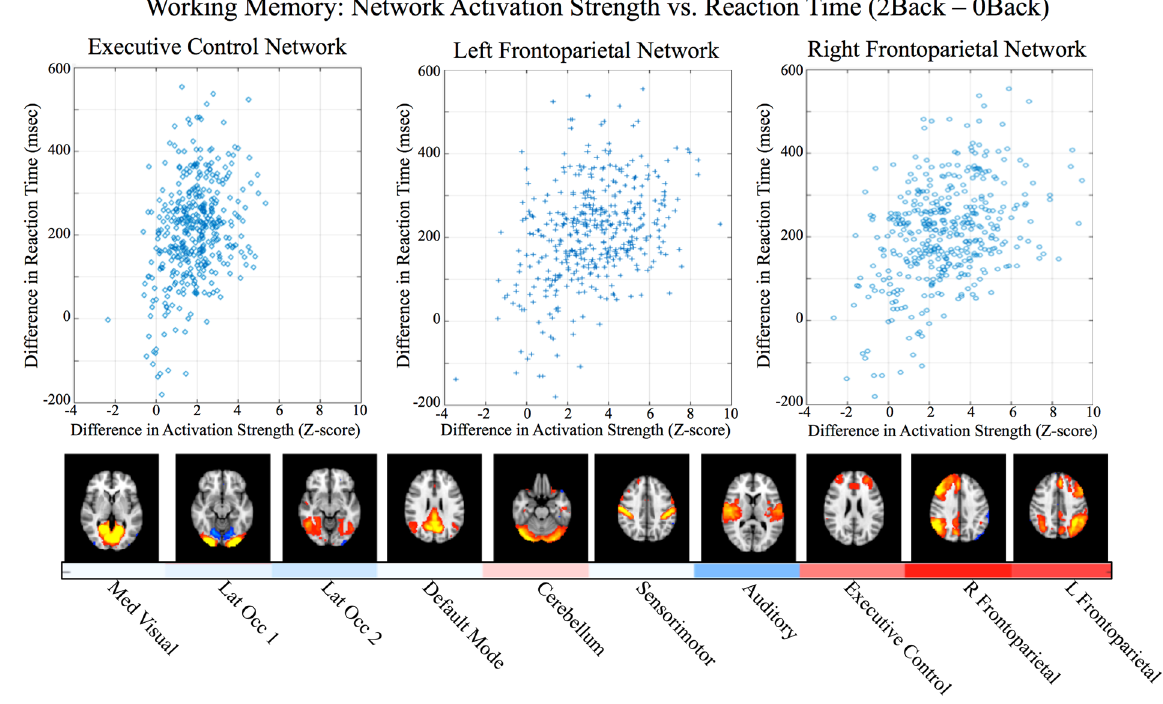
Figure 3. Working Memory Task. Activation strength of each network is shown in the color bar at the bottom of the network images ([red/white/blue] corresponding to range of Z-values of [ + 6/0/6]), with cerebellum, executive control, and left and right frontoparietal networks significantly activated (p < 0.0001, corrected). All other networks are suppressed (p < 0.02, corrected). The difference in brain network activation (2B-0B) was related to the difference in reaction times (2B-0B) for the three cognitive control networks (upper plots, all p < 0.0001,